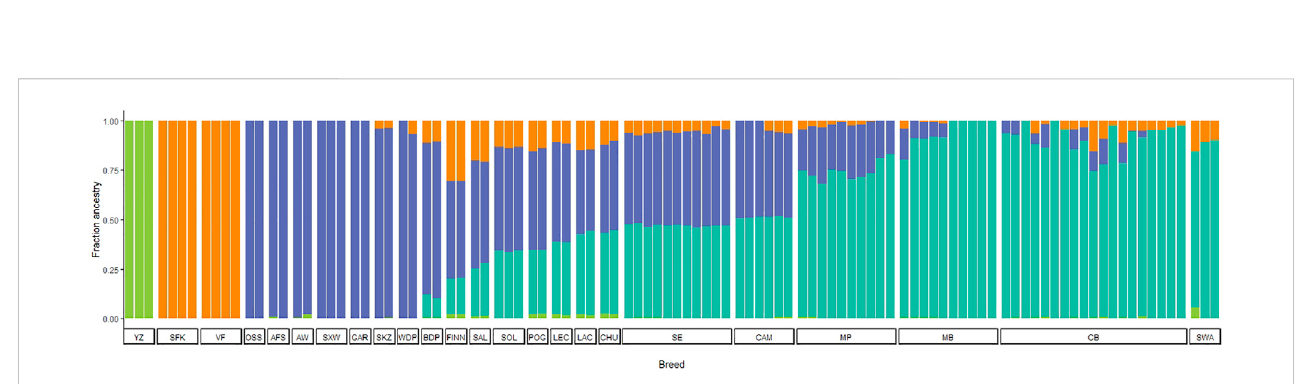
FIGURE 7 Model-based clustering analysis of Iberian and worldwide sheep. The proportions of the inferred ancestral clusters (K = 4) are depicted by the different colours with each individual represented by a bar and sorted by breed. CAM — Campaniça; MB — Merino Branco; MP — Merino Preto; SE — Serra da Estrela; and CB — Crossbreds. The results for K = 2 to K = 21 are shown in Supplementary File S2. See Supplementary Table S2 for details on each individual included in the